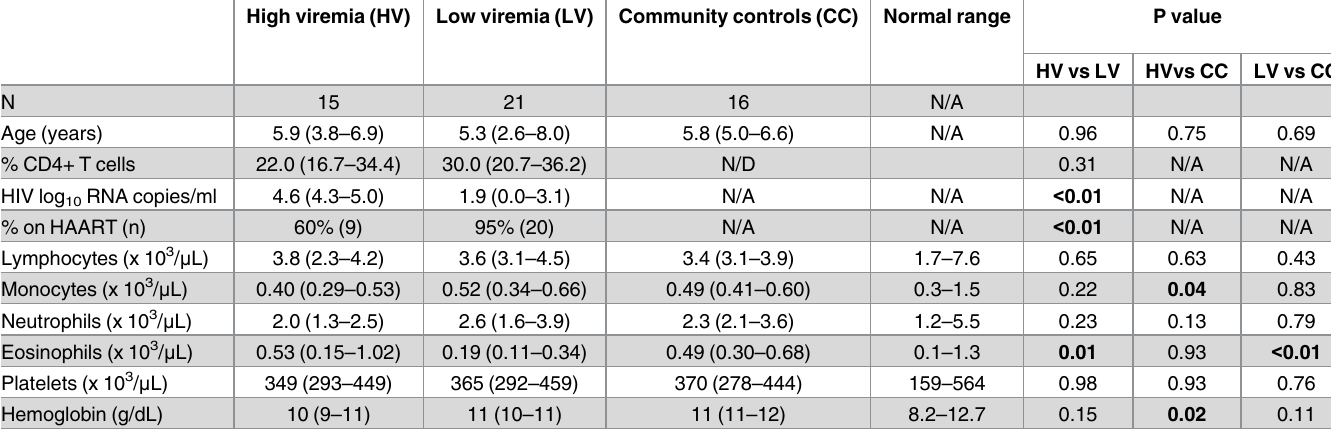
Table 1. Characteristics of the study